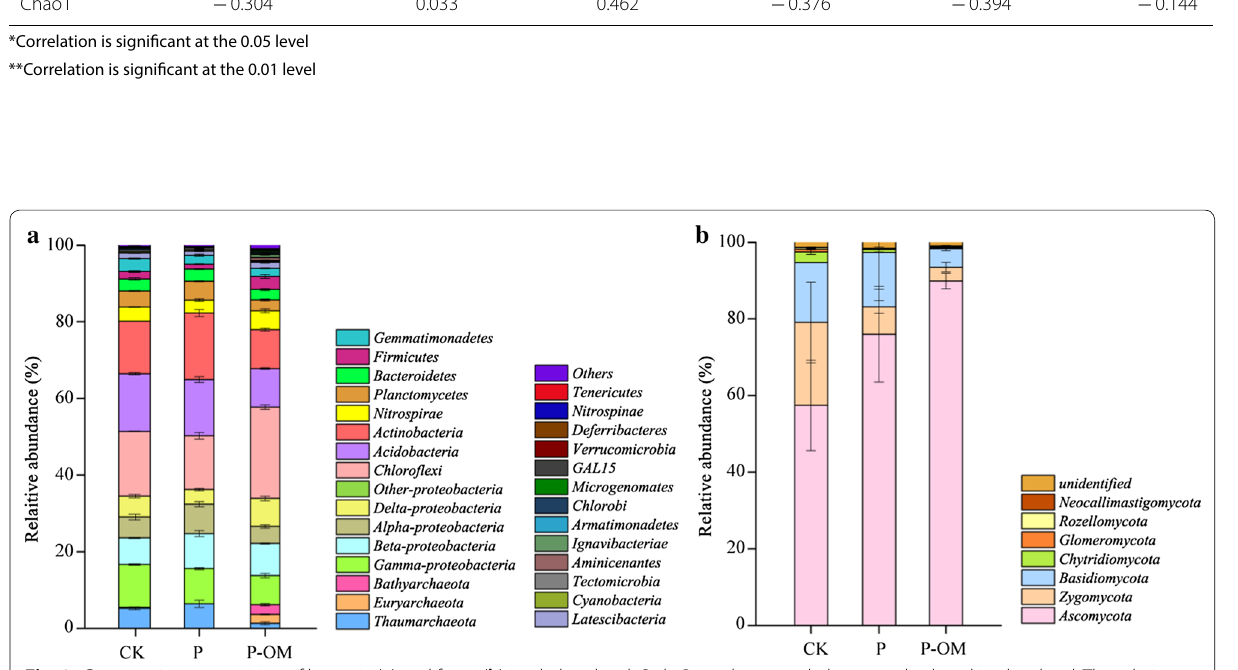
*Correlation is significant at the 0.05 level